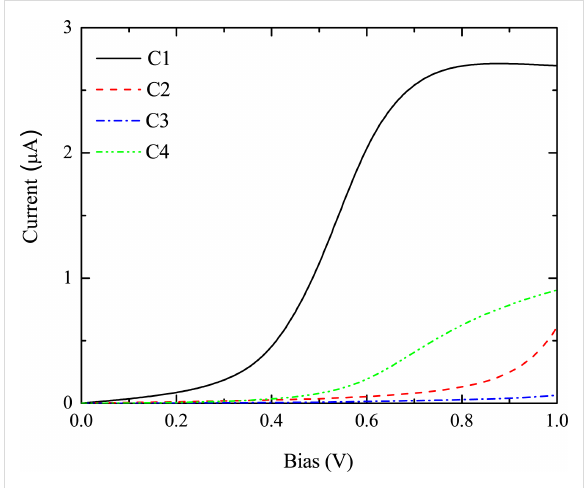
Figure 6: Current–voltage characteristics of a Co/OF/Co junction for the four magnetization configurations C1, C2, C3, and C4 shown in Figure 5c. Reproduced with permission from [32], copyright 2014 AIP